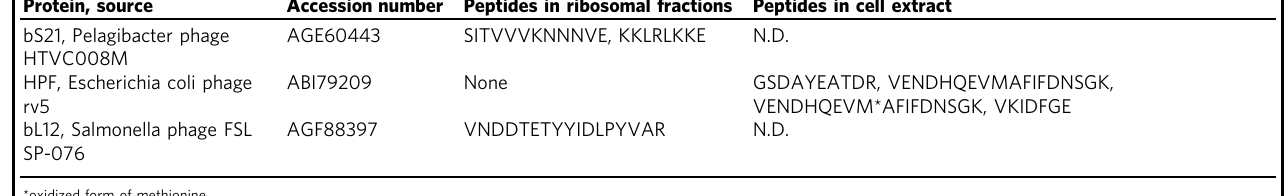
Table 2 bS21, bL12, and HPF peptides identi fi ed by mass spectrometry in ribosome preparations and crude cell extract Protein, source Accession number Peptides in ribosomal fractions Peptides in cell